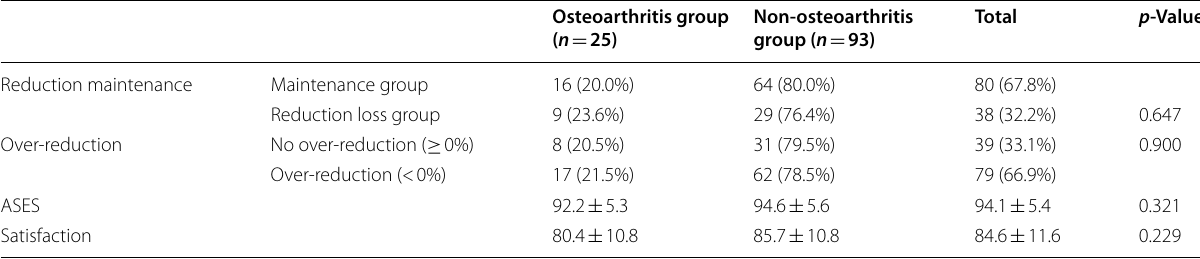
Data are presented as number (percentage) or mean Table 4 Comparison of radiographic and clinical factors between the osteoarthritis and non‑osteoarthritis groups